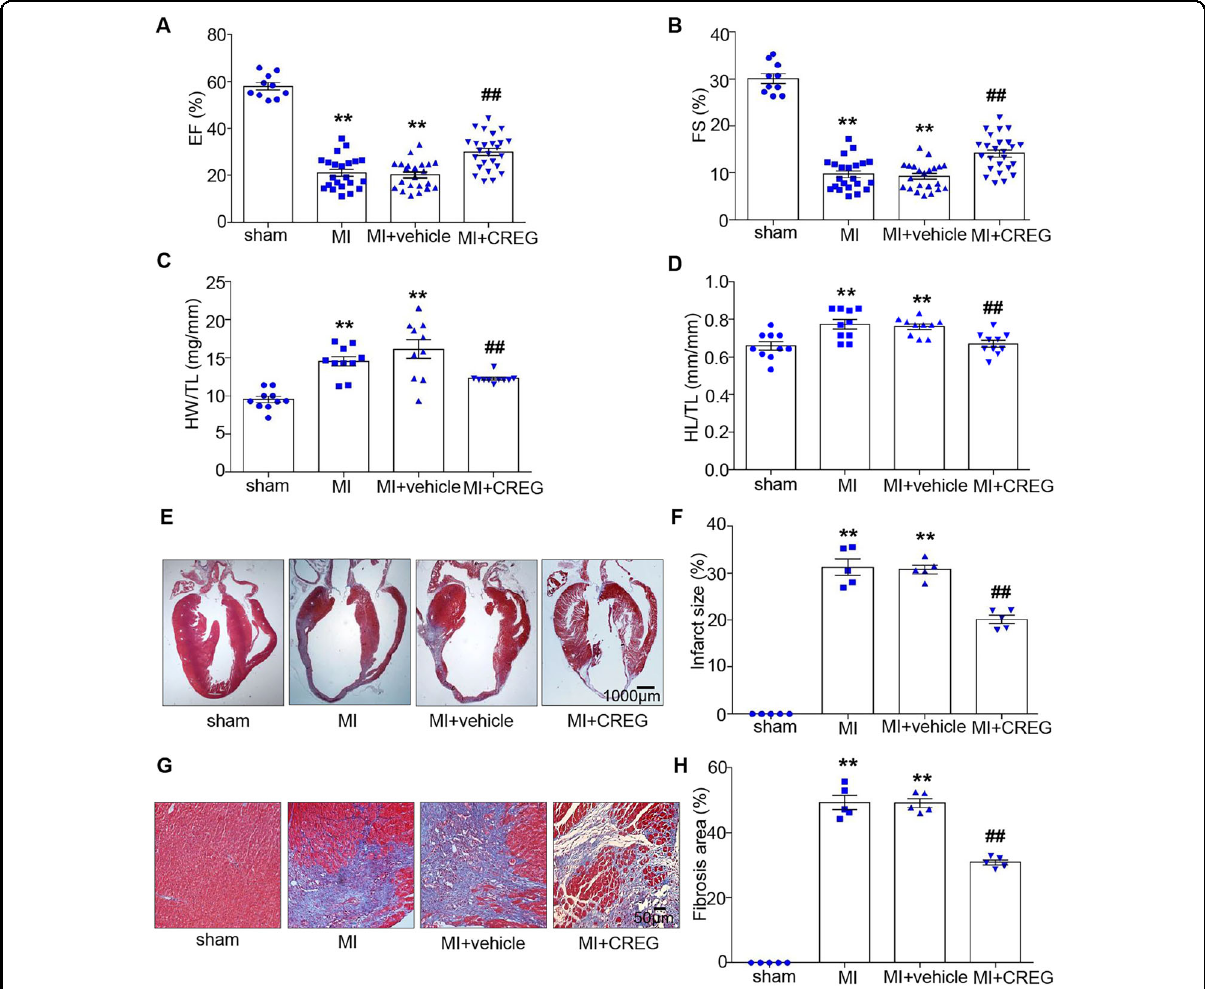
Fig. 3 CREG protein alleviated cardiac dysfunction and cardiac fi brosis on day 14 after MI. A , B EF% and FS% in C57BL/6J mice with overexpression of exogenous CREG on post-MI day 14 ( N = 10 in sham group; N = 22 in MI and MI + vehicle groups; N = 25 in MI + CREG group). C , D The heart weight-to-tibial length (HW/TL) ratio and heart length-to-tibial length (HL/TL) ratio in C57BL/6J mice with overexpression of exogenous CREG on post-MI day 14 ( N = 10 per group). E , F Masson trichrome staining in C57BL/6J mice with exogenous CREG recombinant protein on post-MI day 14 ( N = 5 per group). G , H Fibrosis in the border zone tissue in C57BL/6J mice with overexpression of exogenous CREG on post-MI day 14 ( N = 5 per group). ** P < 0.01 vs. sham group; ## P < 0.01 vs. MI + vehicle